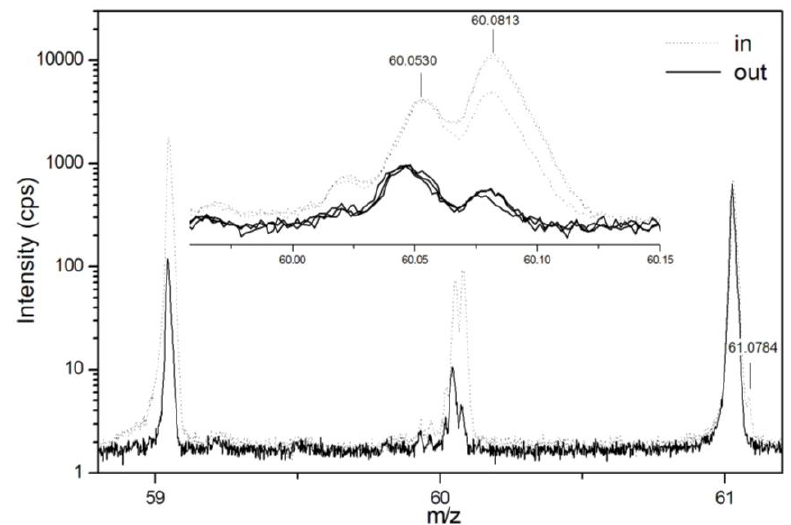
Figure 6. Excerpt of the PTR-TOF-MS spectra of six samples collected upstream (dotted lines) and downstream (continuous lines) a biofilter. The upper panel is a detail of the peak at m/z = 60. Numbers indicate the expected exact mass of protonated monosubstituted acetone isotope (60.053) and of protonated trimethylamine (60.0813). At mass 61.0784 the mono substituted isotope of trimethylamine is also indicated. Reprinted from [129], with permission from the copyright holders, IWA